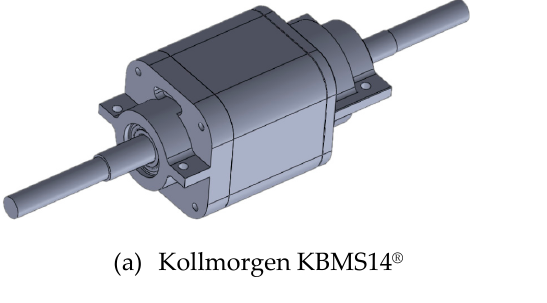
Figure 8. Actuation and transmission components.